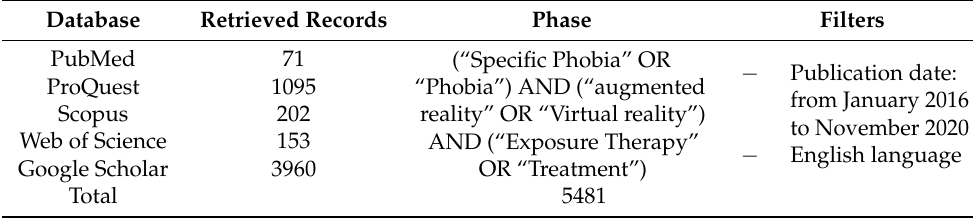
Table 4. Existing research in the selected databases using the search strategy.